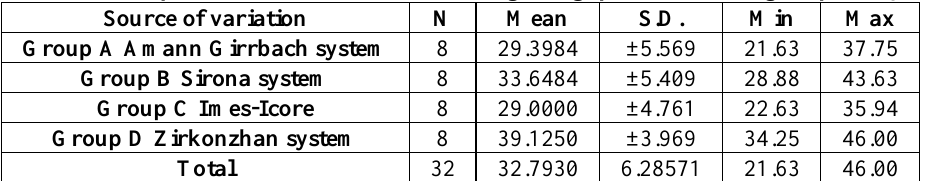
Table 1: Descriptive statistics of vertical marginal gap for the four groups in (µm)